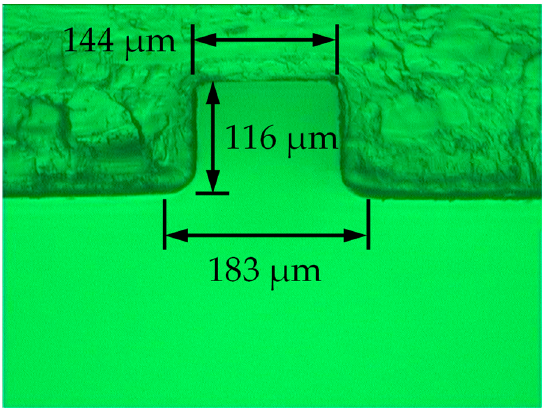
Figure 5. An image of the plastic transverse micro groove molded by injection pressure of 60 MPa, injection speed of 100 cm 3 /s, and ultrasonic power of 600 W. injection speed of 100 cm 3 /s, and ultrasonic power of 600